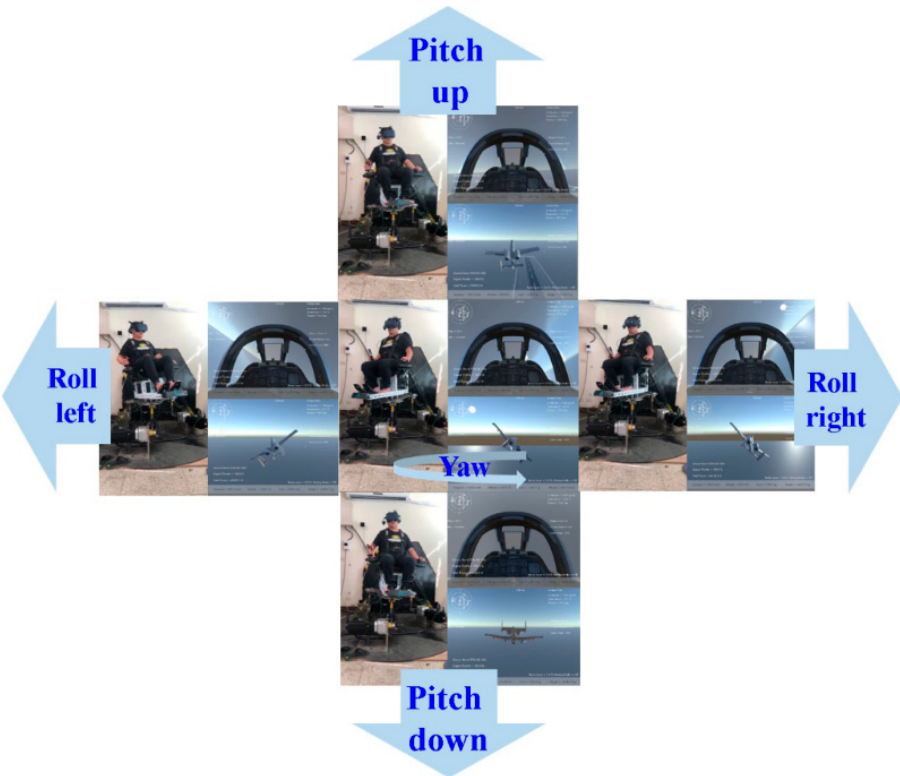
Figure 33. Operating state of the system.